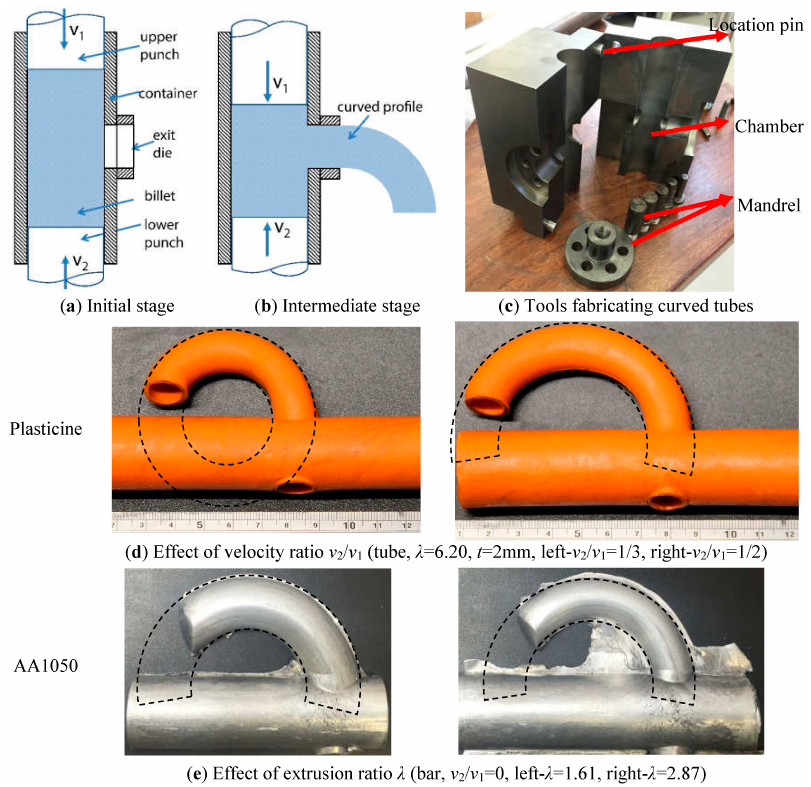
Figure 26. Differential velocity sideways extrusion (DVSE) process for fabricating curved profiles [99,100]. Reproduced with permission from ref. [99]. Copyright 2017 Elsevier Ltd.